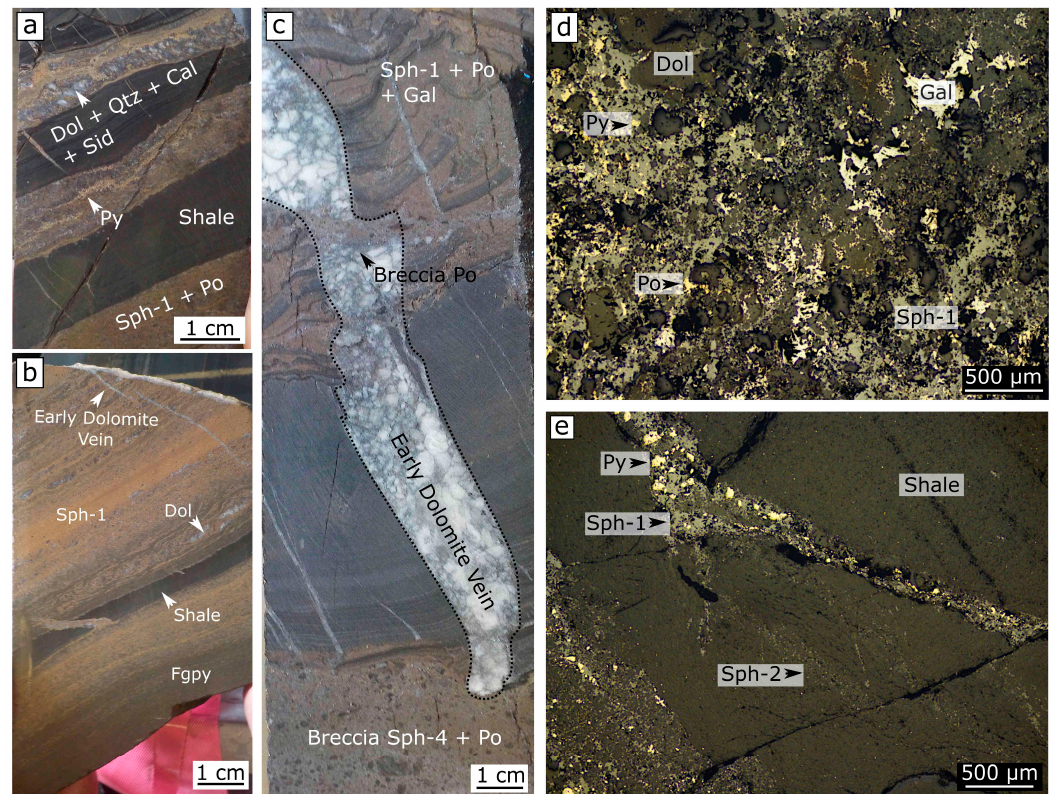
Figure 3. Sphalerite paragenesis at the Hilton Zn-Pb (Ag) deposit. ( a ) Sph-1 replacing a stratabound pre-mineralisation dolomite + quartz + calcite + siderite vein. ( b ) Sph-1 dominated stratabound mineralisation that is crosscut by an early ferroan dolomite vein. ( c ) Stratabound Zn mineralisation crosscut by an early dolomite vein. The early dolomite vein terminates at the interface of a Zn-dominated breccia. ( d ) Reflected light photomicrograph showing sph-1 with co-crystallising pyrite, pyrrhotite and galena. ( e ) Reflected light photomicrograph showing fine-grained disseminated sph-2 splaying from a sph-1 vein. Abbreviations: qtz = quartz, cal = calcite, sid = siderite, sph = sphalerite, dol = dolomite, fgpy = fine-grained pyrite, py = pyrite, gal = galena, po = pyrrhotite.